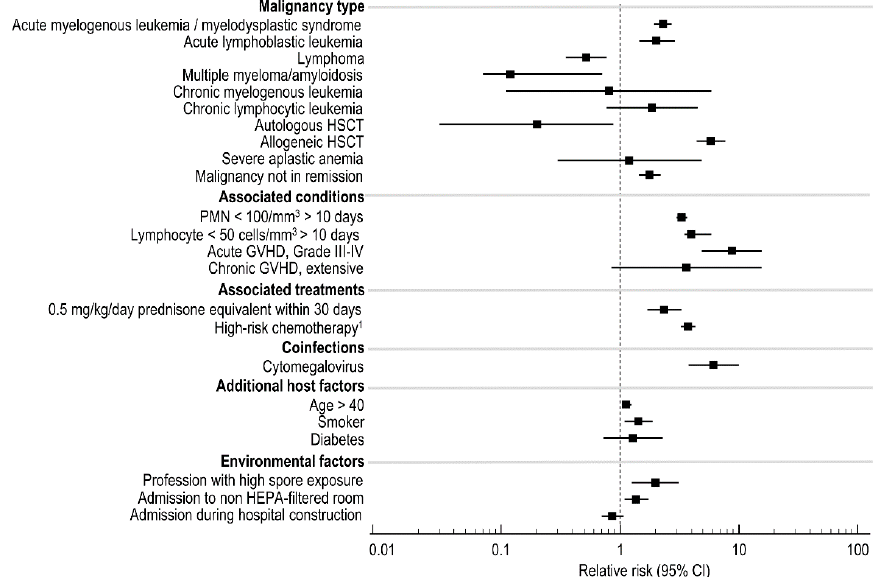
Figure 3. Risk factors in univariate analysis associated with the development of EORTC/MSG defined probable or proven invasive mold disease ( n = 133) among 1,944 adult inpatients ( n = 4,127 admissions) undergoing treatment for a hematological malignancy from 2007–2016 at the Seràgnoli Hematology Institute in Bologna, Italy.